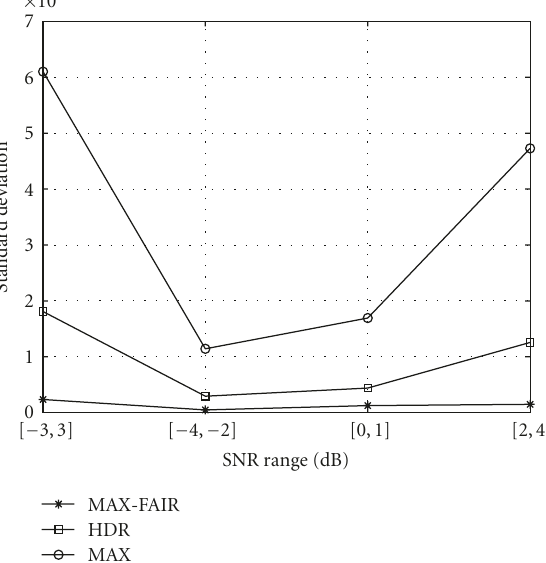
Figure 5: Standard deviation of achievable average